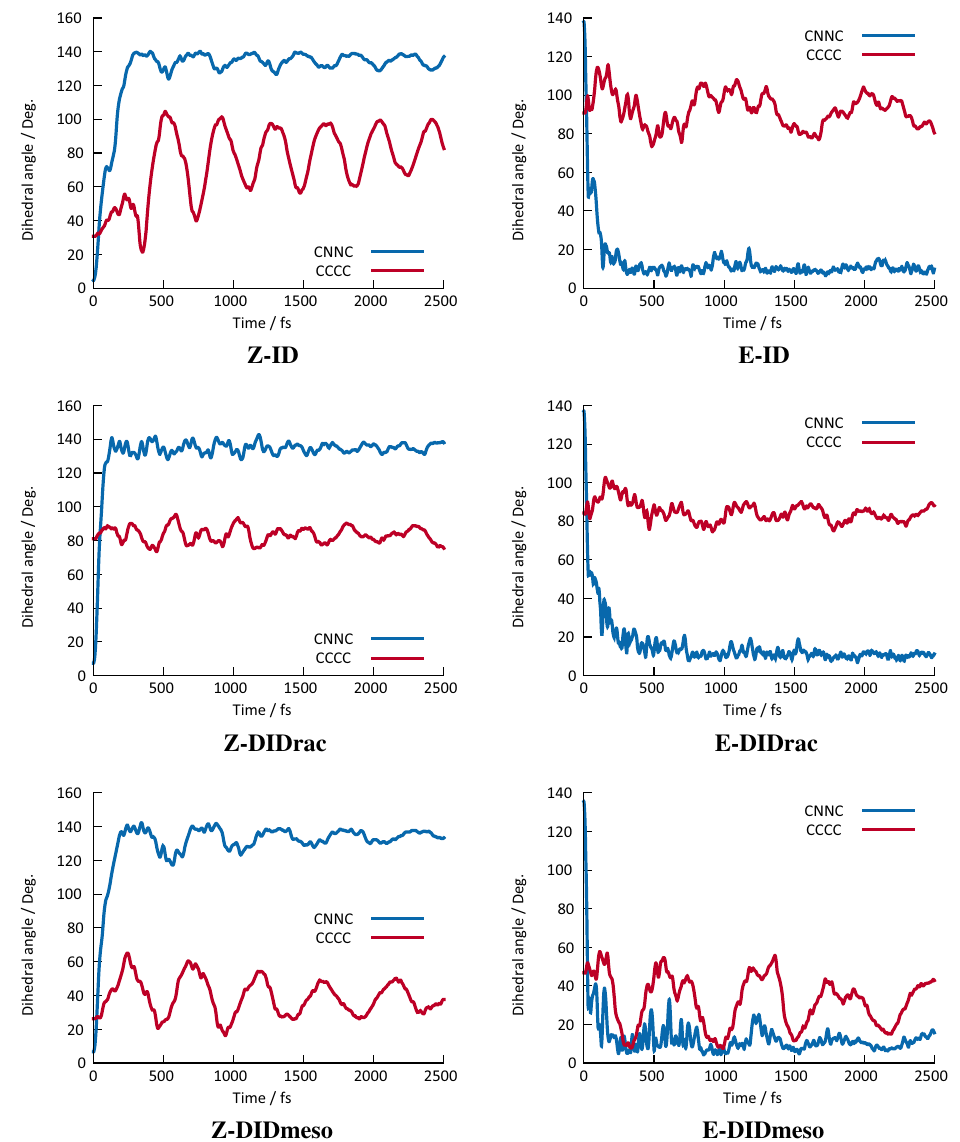
Figure 6. Time progression for the CNNC and CCCC dihedrals for the studied compounds. The graphs show the values after averaging over all reactive trajectories.